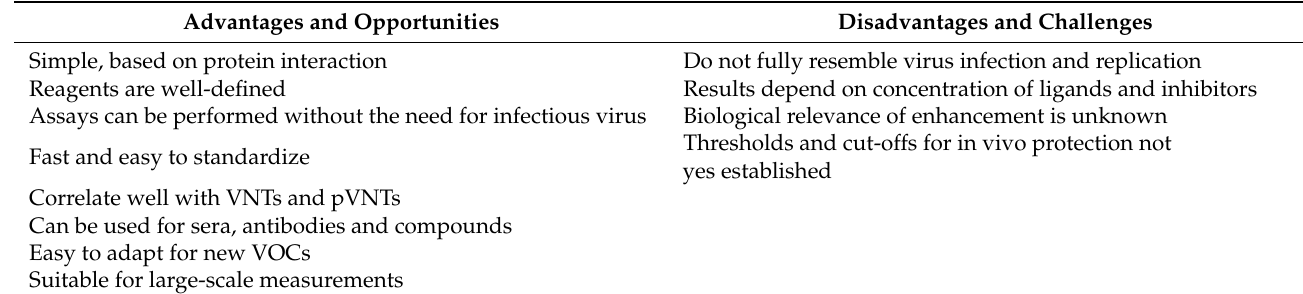
Table 3. Advantages and challenges of